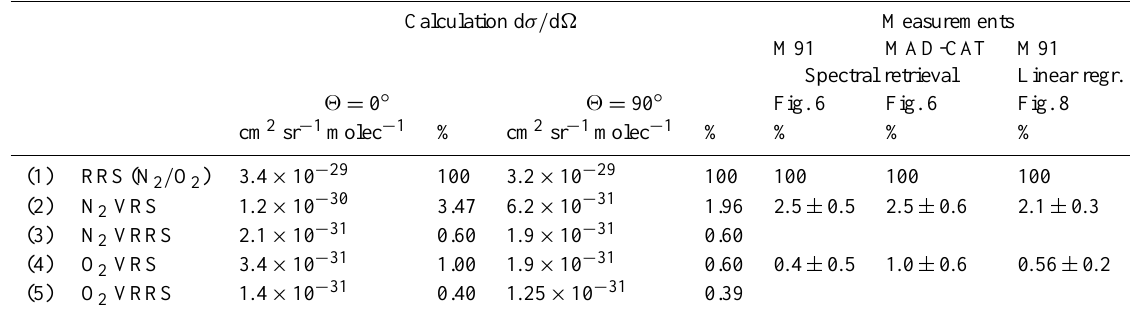
cm 2 sr − 1 molec − 1